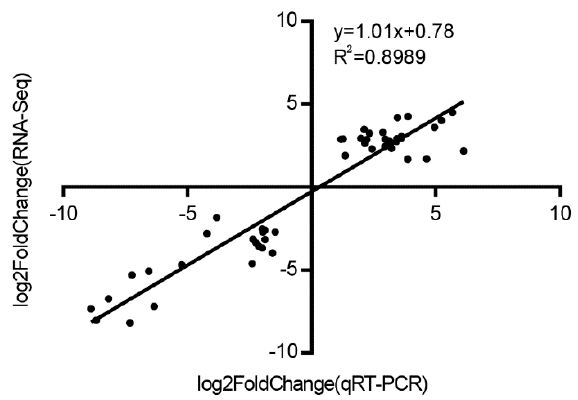
Figure 9. The expression correlation of eight DEGs between quantitative real-time PCR (qRT-PCR) and RNA-Seq data under cold and heat stresses.